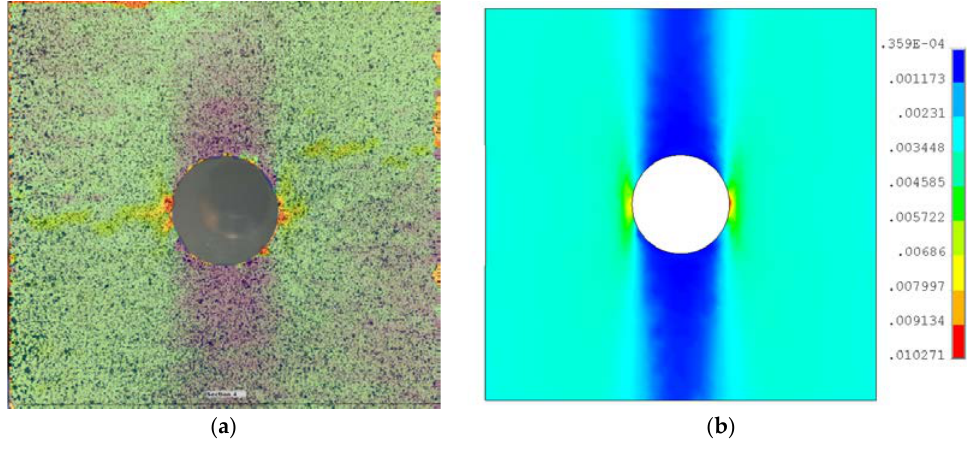
Figure 12. Area monitored by digital-image correlation (DIC) ( a ) and finite element (FE) simulation ( b )—woven-roving composite.